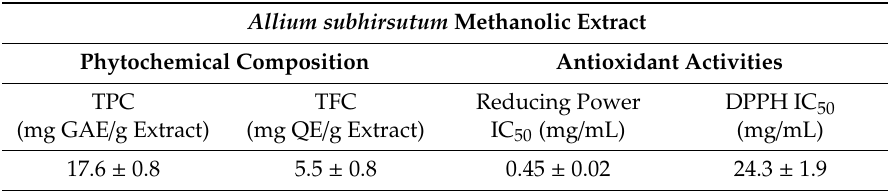
Table 4. Antioxidant content and activities of Allium subhirsutum methanolic